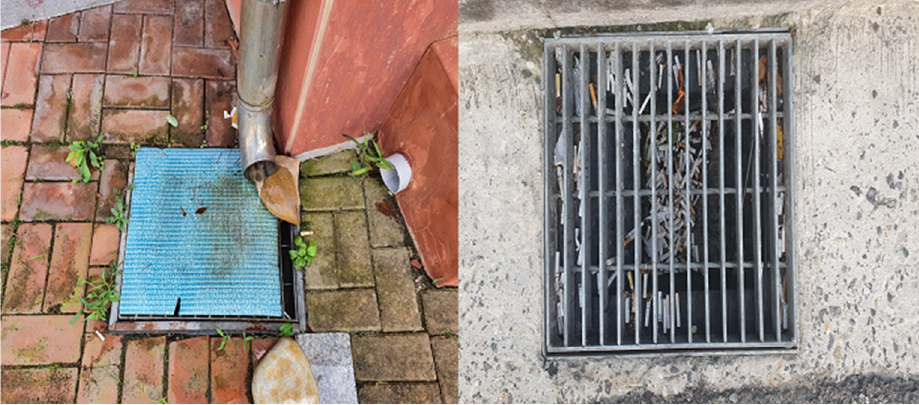
Figure 4. Performance degradation of rainwater collecting trenches. ( left : unexpected cover installa- tion; right : cigarette butts in the grating